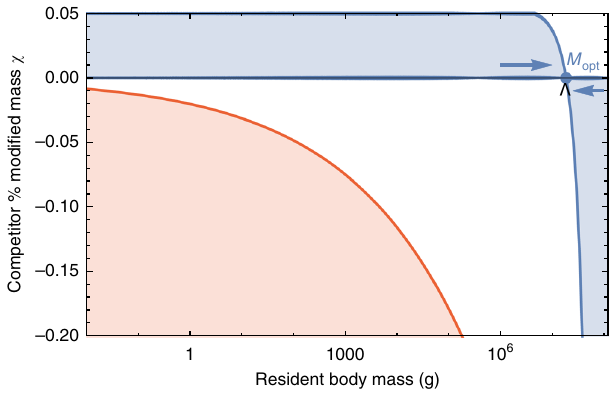
Fig. 5 Competitive outcomes for a resident species with body mass M vs. a closely related competing species with modi fi ed body mass M ′ = M (1 + χ ). The blue region denotes proportions of modi fi ed mass χ resulting in exclusion of the resident species. The red region denotes values of χ that result in a mass that is below the starvation threshold and are thus infeasible. Arrows point to the predicted optimal mass from our model M = 1.748 × 10 7 , which may serve as an evolutionary attractor for body opt mass. The black wedge points to the largest body mass known for terrestrial mammals ( Deinotherium spp.) at 1.74 × 10 7 g